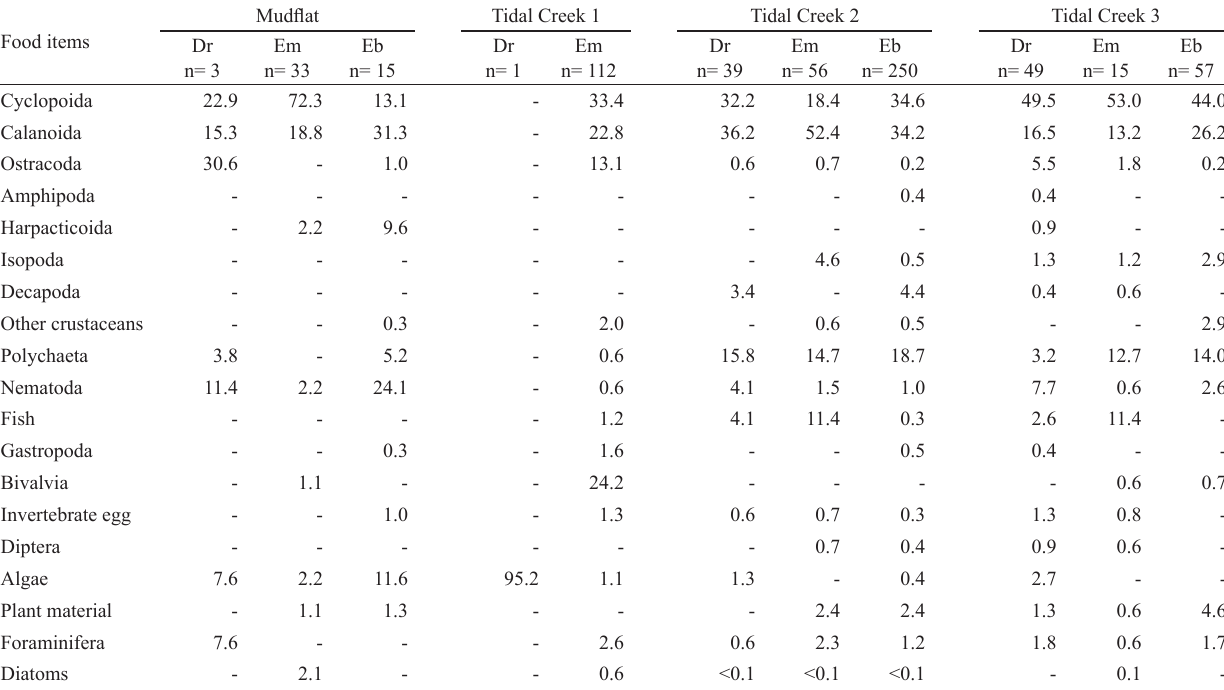
Table 5. Percentage volume (%V) values of feeding items used by Diapterus rhombeus (Dr), Eucinostomus melanopterus (Em) and Eugerres brasilianus (Eb) in each site of the rio Mamanguape estuary, northeastern Brazil. n= number of individuals. Food items